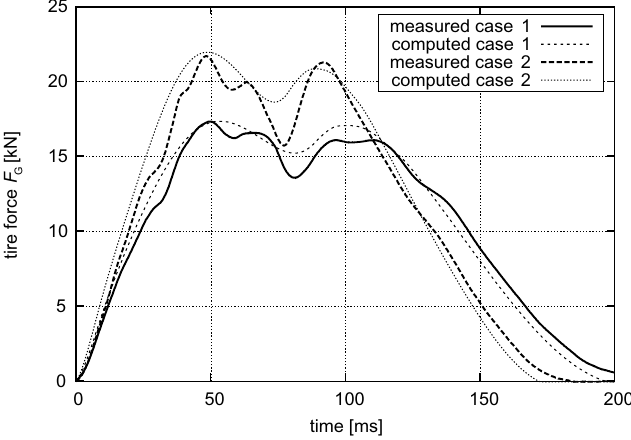
Fig. 3. Measured and computed tire force F G , passive LG: test case 1 ( m = 422 kg , v 0 = 2 . 93 m / s , L = 0 . 667 ); test case 2 ( m = 422 kg , v 0 = 3 . 52 m / s , L = 1 ).